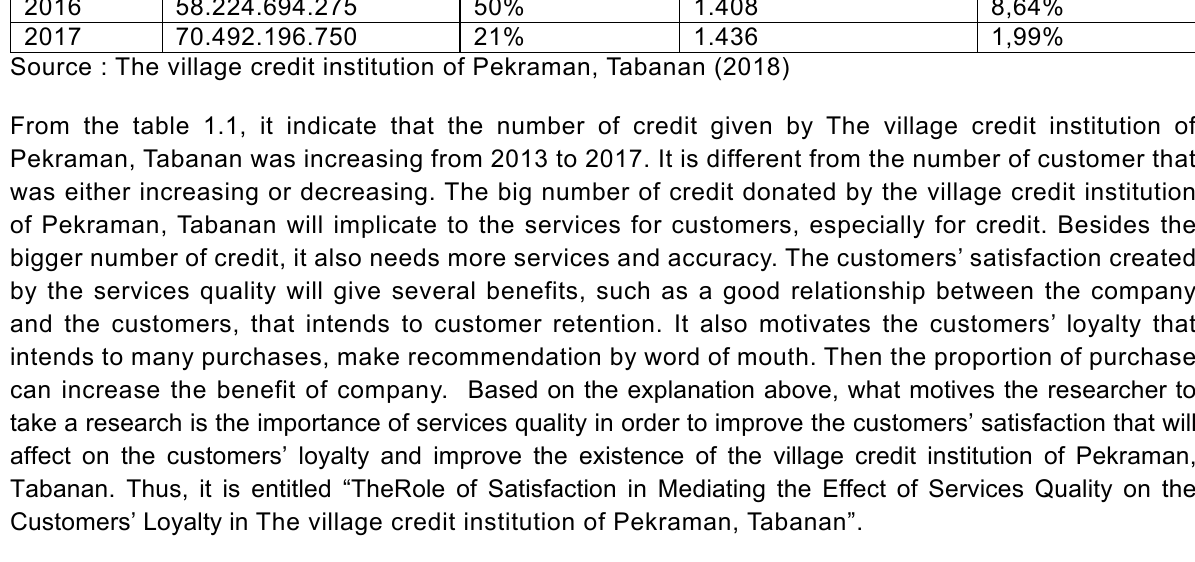
Table 1: The Number of Credit and Customer in The Village Credit Institution of Pekraman, Tabanan from 2011 to 2017 Number of Credit Percentage Percentage Year Number of Customer Rp. % % 2013 27.834.464.425 - 1.285 - 2014 30.151.247.125 8% 1.304 1,48% 2015 38.872.280.625 29% 1.296 2016 58.224.694.275 50% 1.408 2017 70.492.196.750 21%